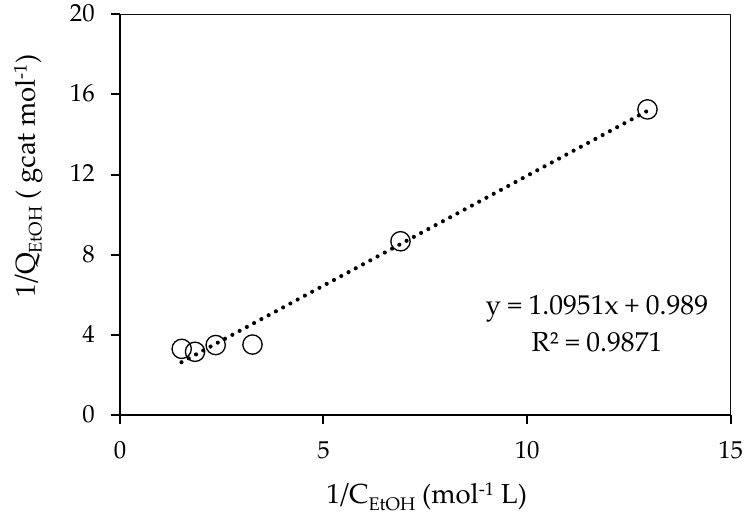
Figure 7. Linearized Langmuir equilibrium isotherm for ethanol on 0.25 wt% Pd-TiO 2 . Table 1. Adsorption Constants for Ethanol when Using the 0.25 wt% Pd-TiO 2 .